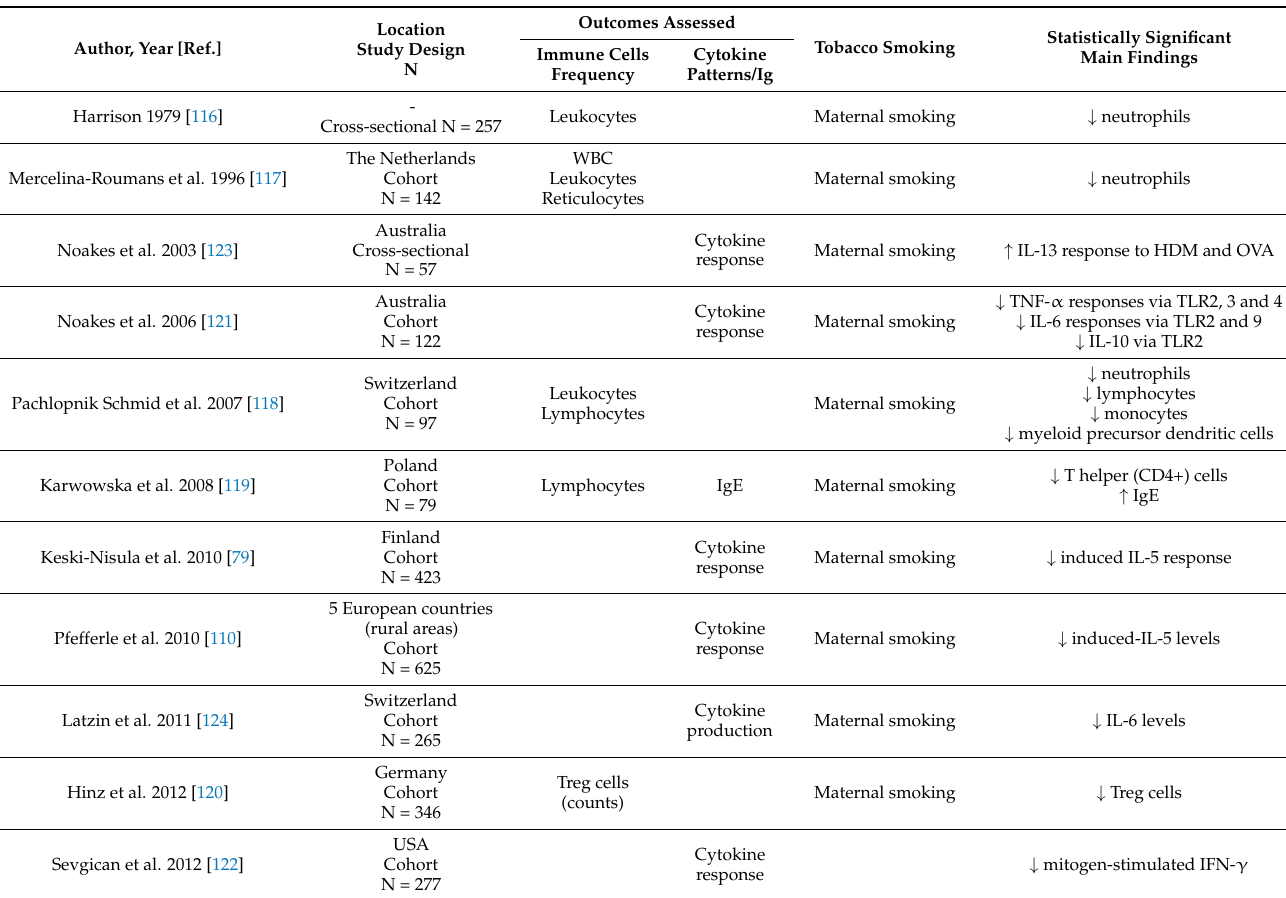
Table 4. Prenatal exposure to tobacco smoking and changes in the immune system of neonates (authors ordered by year and then